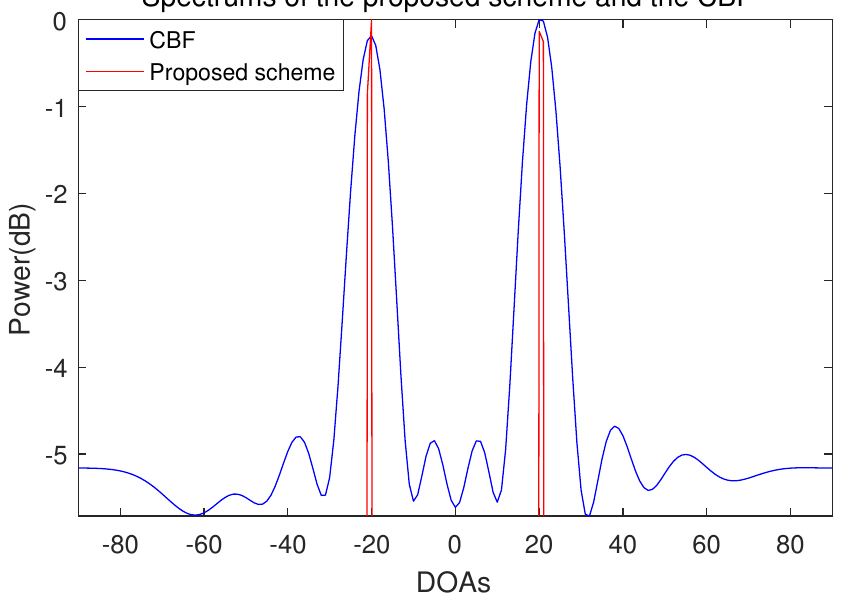
Figure 3. Spectrum of the proposed scheme and the conventional beamforming algorithm when the number of sensors is 10, the number of samples is 500, and the incident angles are − 20 ◦ and 20 ◦ (SNR = − 10